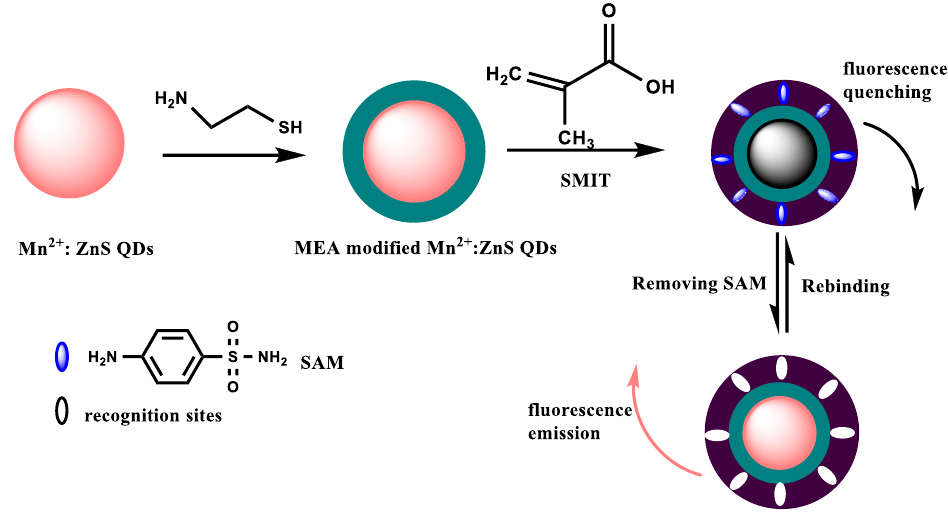
Figure 1. Schematic of the preparation of the MIP@QDs-based sensor. SMIT: surface molecular imprinting technique; SAM: sulfanilamide; MEA: mercaptoethylamine.